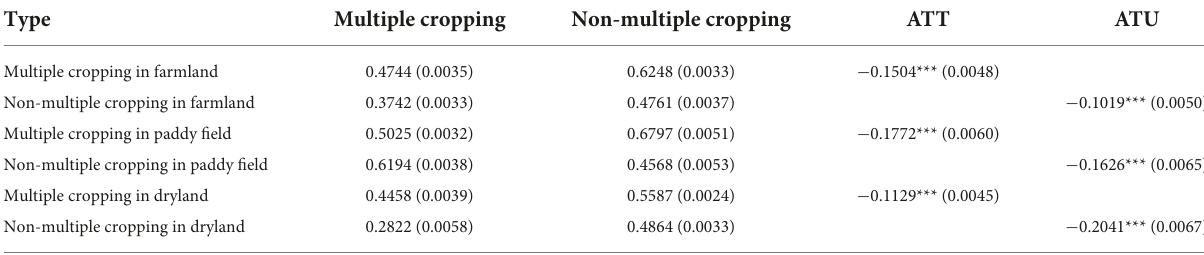
TABLE 9 The average treatment effect of multiple cropping of various types of farmland on relative poverty before the equivalent scale adjustment.